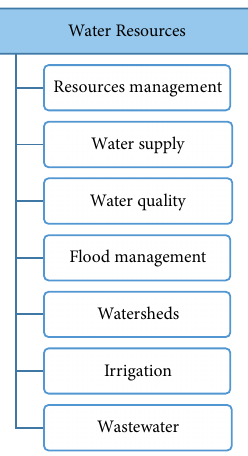
Fig. 5. Research domains in water